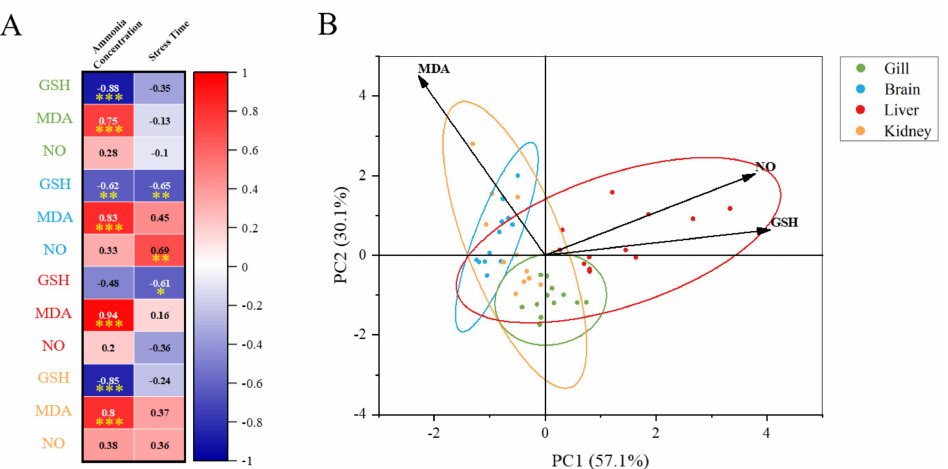
Figure 9. Multi − parameter integration analysis. ( A ) The Pearson’s correlation heat map of bio- chemical parameters (GSH, MDA, and NO). Asterisks (* p < 0.05; ** p < 0.01; *** p < 0.001) indicate significant difference between the two groups; ( B ) principal component analysis (PCA) plots for biochemical parameters in different tissues under ammonia